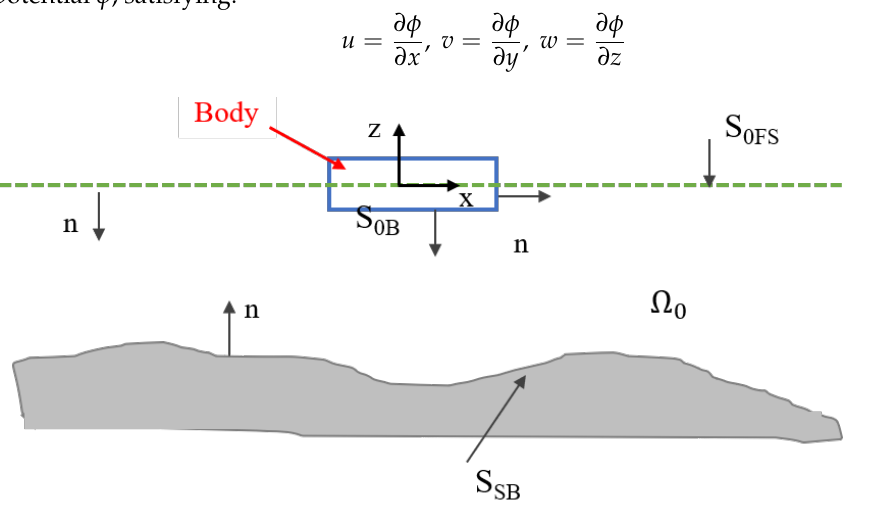
Figure 1. Boundary conditions for linear waves.